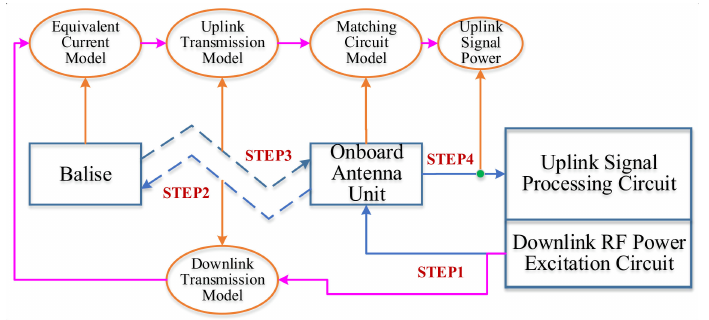
Figure 3. Schematic diagram of mutual inductance model between balise antenna and onboard